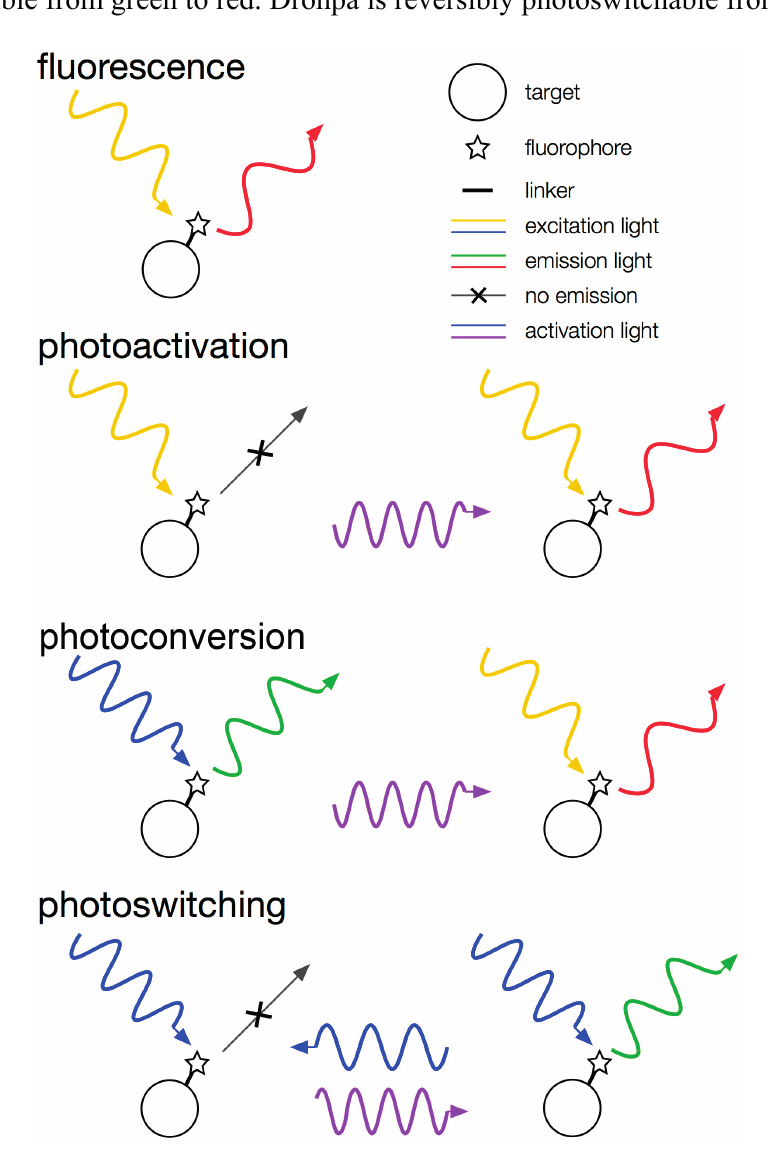
Figure 4. Categories of fluorescent proteins. mCherry is an example of a typical fluorescent emitter. PAmCherry is photoactivatable from off to on. Dendra2 is photoconvertible from green to red. Dronpa is reversibly photoswitchable from off to